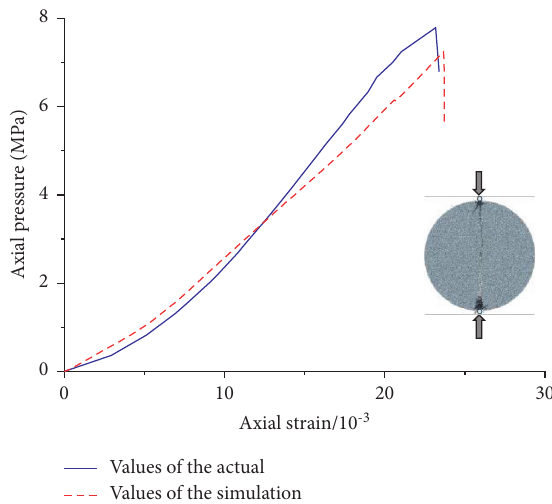
Figure 8: Brazilian split stress-strain curve of the actual and numerical simulation